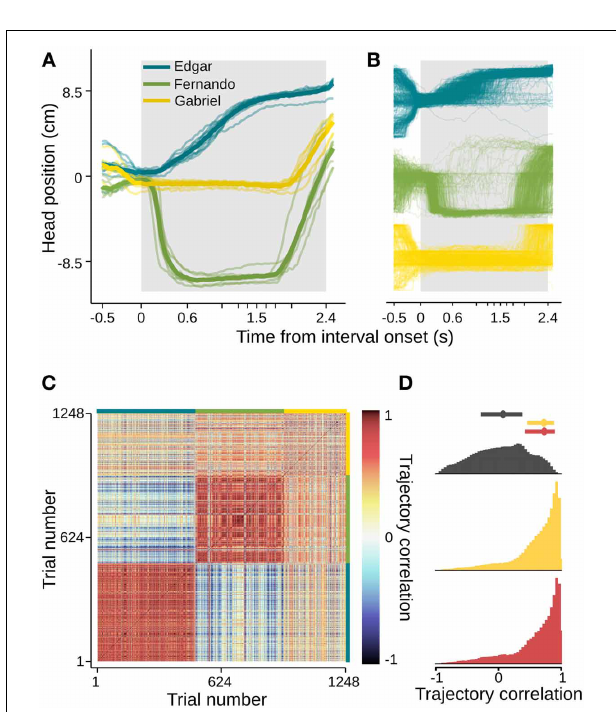
averaged across all presentations of the longest interval (I = 2.4s). Times when frames were taken are indicated in seconds relative to interval onset. n = 62 trials.